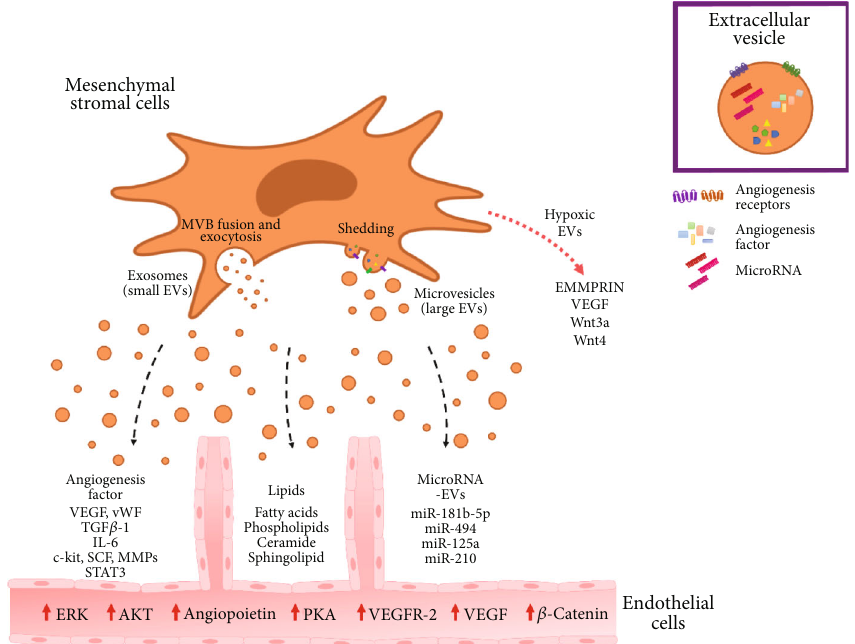
Figure 2: EV-mediated paracrine action of MSCs in angiogenesis. MSCs release EVs that are enriched in angiogenic factors such as cytokines, chemokines, and growth factors as well as miRNAs and lipids. Transferring of MSC-derived EV cargo to recipient endothelial cells triggers proangiogenic signaling important to tissue repair. In response to hypoxia, MSCs release EVs with an increased angiogenic potency capable of activating targeted signaling pathways to regulate the expression of angiogenic factors in endothelial